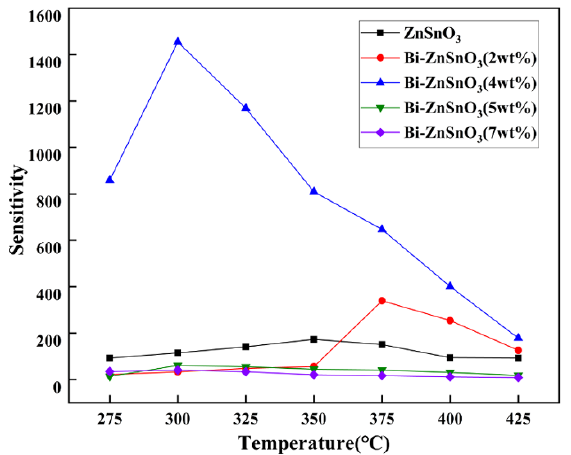
Figure 7. Temperature response curves of pure ZnSnO 3 and different ratios of Bi-ZnSnO 3 to 100 ppm n-butanol gas.